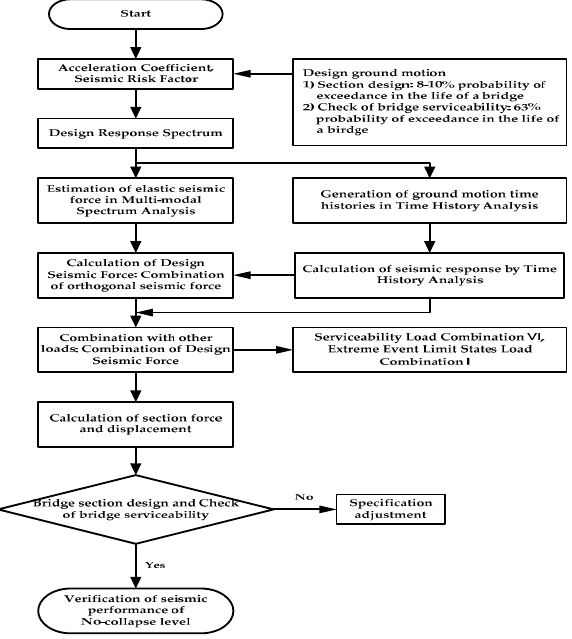
Figure 15. Present seismic design procedure using a performance-based design method in Korean Highway Bridge Design Code (Limit State Design) for Cable Supported Bridges.